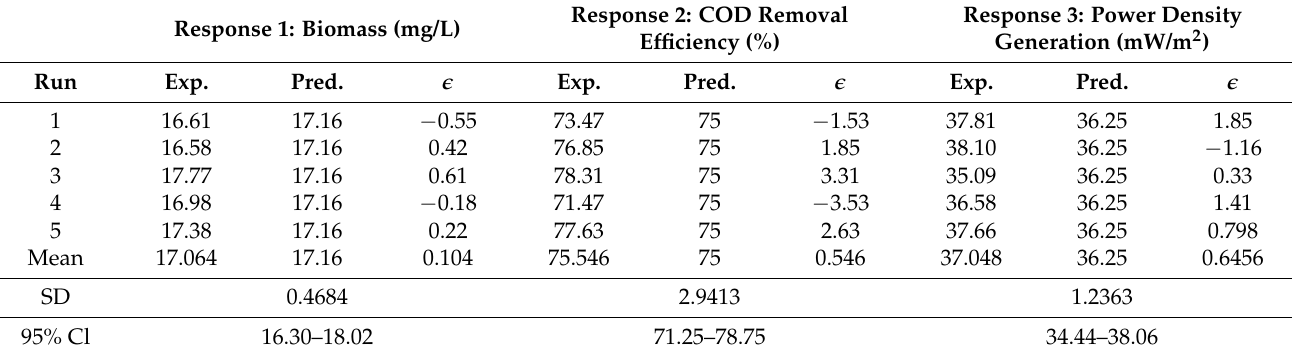
Table 5. Comparison between experimental data and predicted data for the optimal conditions suggested by Design Expert 13